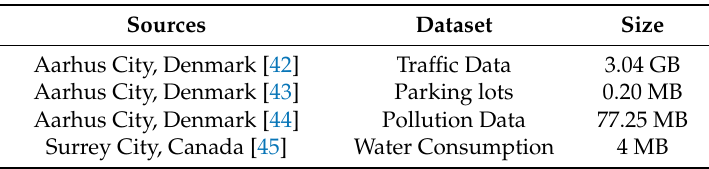
Table 2. Information related to analyzed